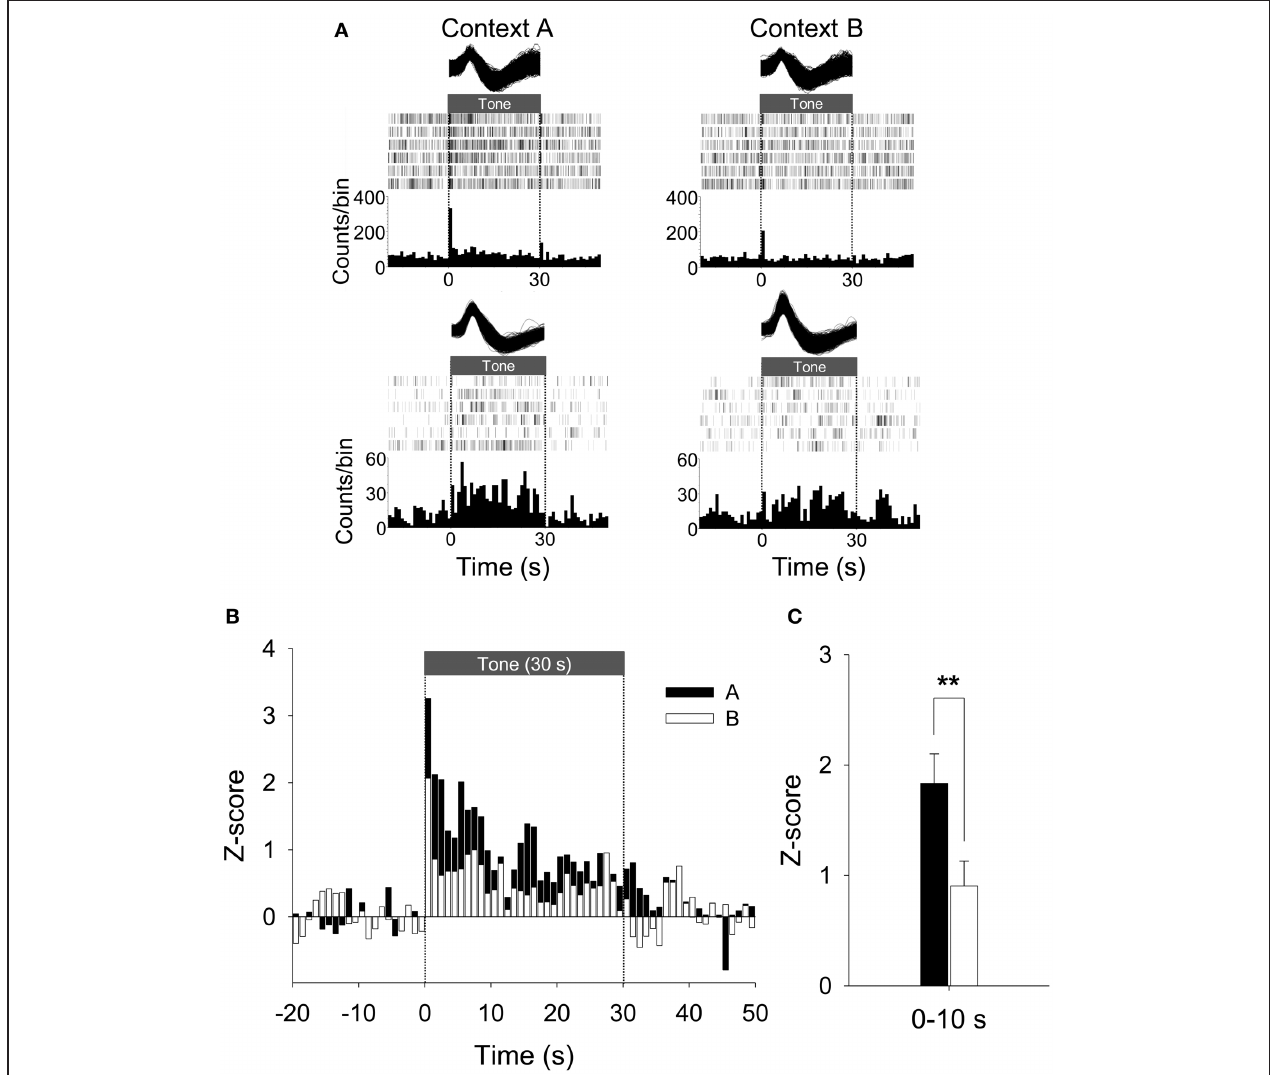
FIGURE 6 | Representative and average activity of PFUs during CDFD. (A) Two representative waveforms of CS-responsive neurons and their raster plots and PSTHs are presented. Both units showed an increased firing rate to the CS in Context A than in Context B. Note that the first representative unit is the same as shown in Figure 5A . (B) The